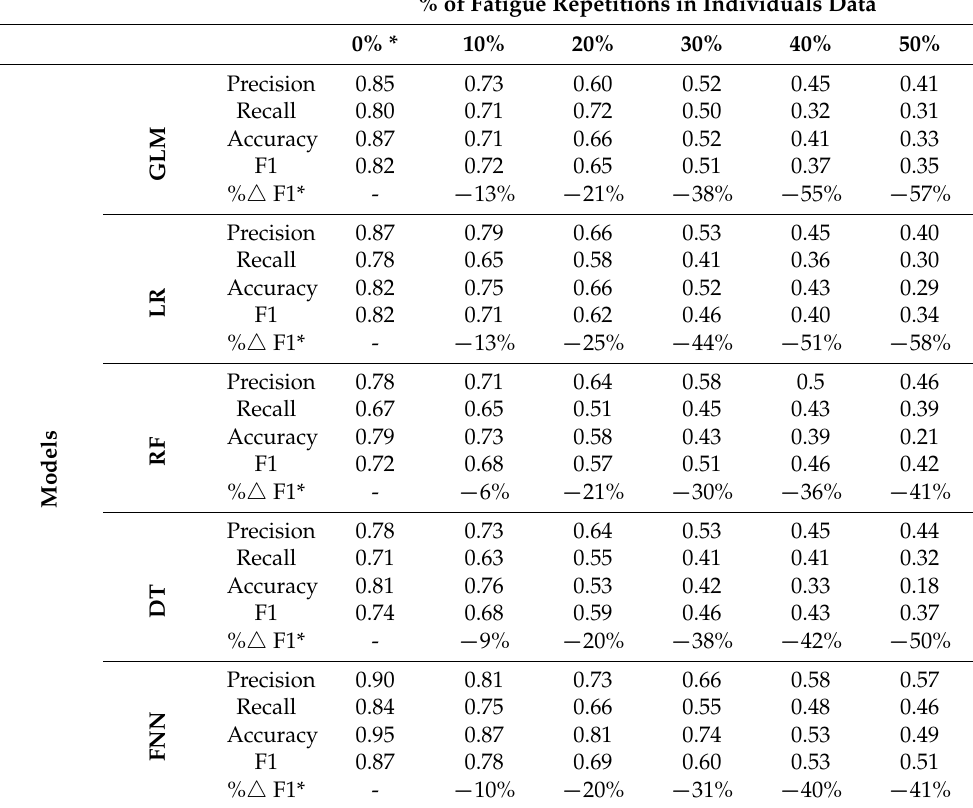
Table 8. The performance averages for cross-subject models to detect biceps repetitions throughout the incremental replacement of fatigue